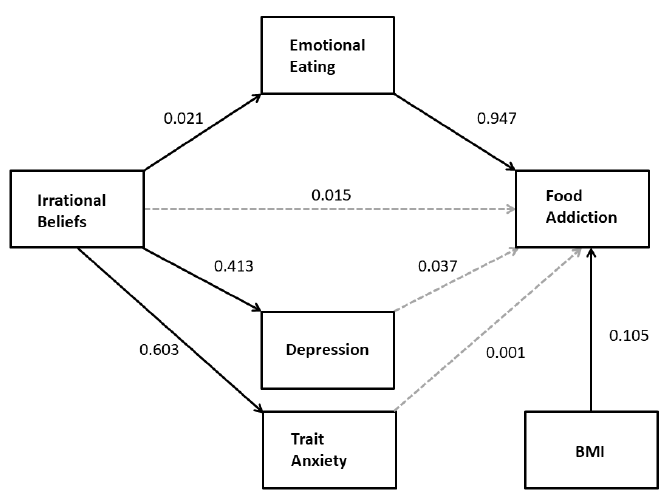
Figure 1. The relationship between irrational beliefs and food addiction (FA) is mediated by emotional eating but not depression or trait anxiety. Solid arrows indicate statistically significant regression coefficients. Nonsignificant BMI effects on mediators are not included for simplicity.